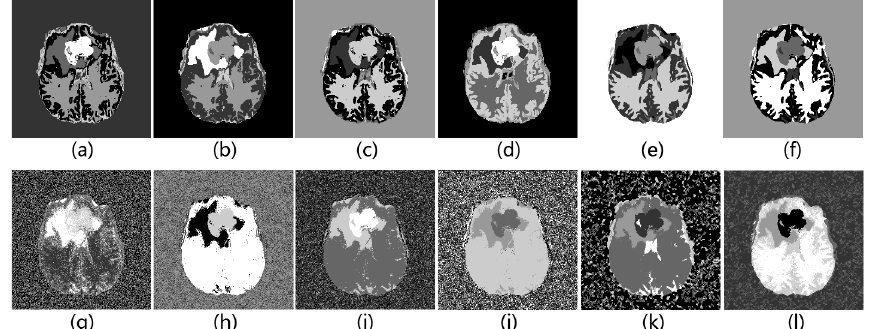
Fig. 4. Visualized clustering results on input image